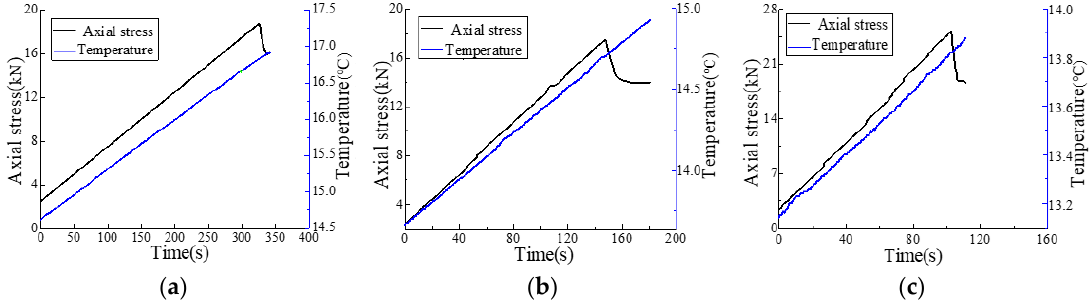
Figure 4. The axial stress and temperature in the same time curve: ( a ) the curve of stress-temperature-time under 50 N/s loading rate; ( b ) the curve of stress-temperature-time under 100 N/s loading rate and ( c ) the curve of stress-temperature-time under 200 N/s. Table 1. Increase slope of temperature-time during loading process.